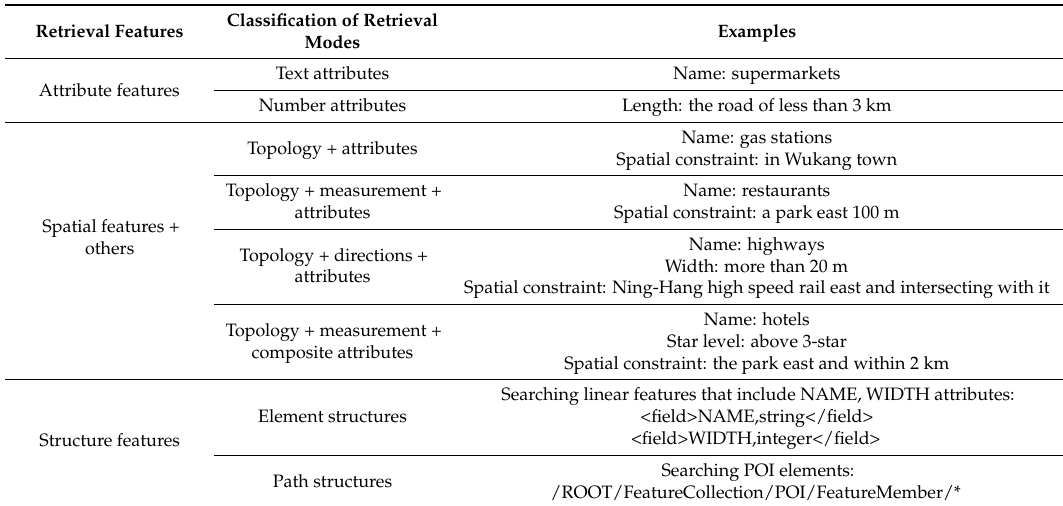
Table 1. Examples GML data retrieval mode.